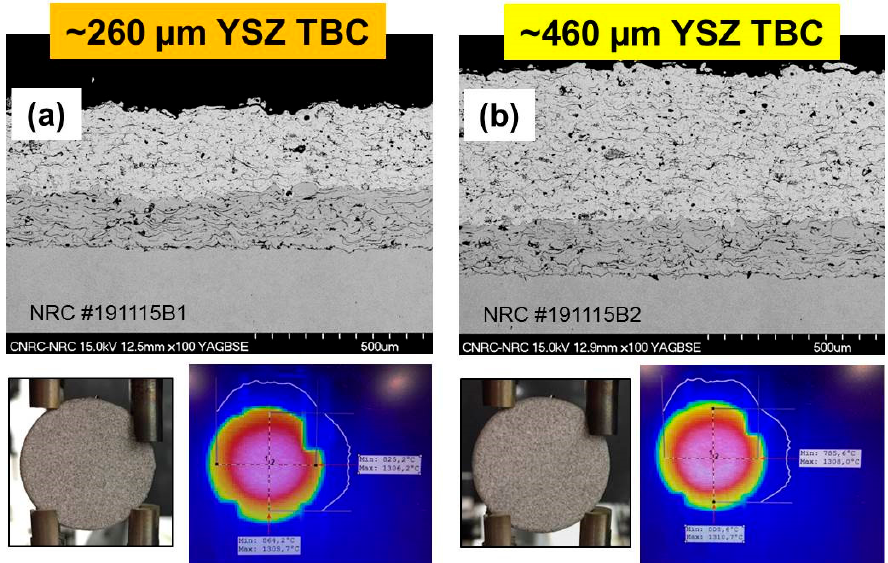
Figure 7. As-sprayed cross-sectional microstructure, sample snap-shot in the laser-rig at setup and